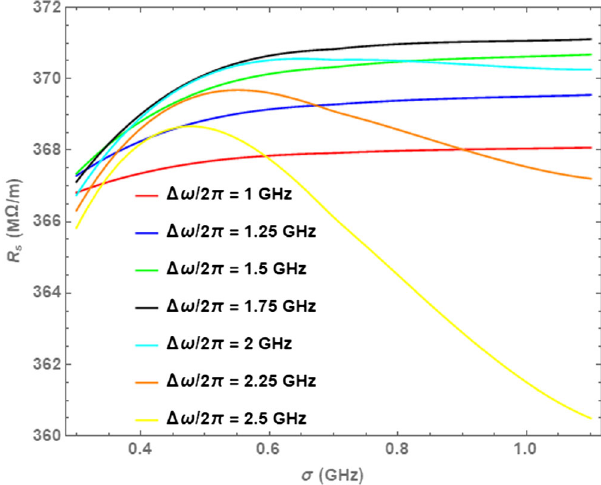
FIG. 20. The effective shunt impedance of the structure as a function of σ for a range of Δ ω where L ¼ 0 . 5 m and h G i ¼ 80 MV = m for this example.